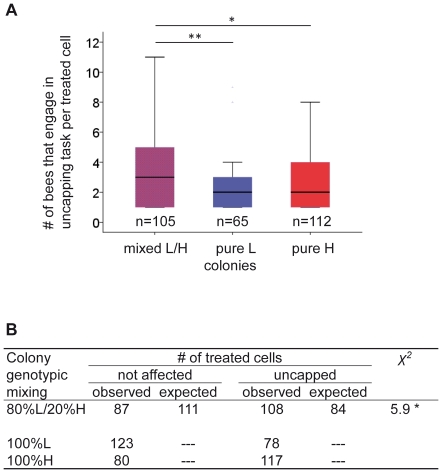
Group behavioral uncapping responses in the mixed L/H and pure L and H bee cages.(A) The number of workers that engaged in uncapping tasks per treated brood cell (boxplot; combined data from different cages). Numbers represent cumulative data from all cages. Medians were compared with the Median-test; * denotes P<0.05, and ** denotes P<0.005. (B) The number of uncapped and non-uncapped cells in a colony as a measure of colony-level performance. The expected value in mixed cages was calculated based on the additive combination of the pure L and H bee colony outcomes and the relative contributions of bees in the mixed cages. * denotes P<0.02. We identified 105 treated brood cells at which bees engaged in uncapping behavior, which were analyzed in (A), and 108 treated brood that were actually uncapped in the different genotypic mixed groups.